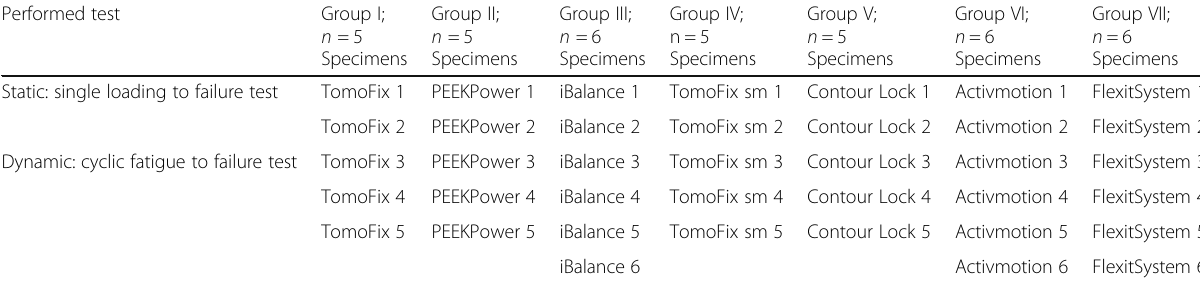
Table 3 Specimen grouping and assignment, depending on used implants and the performed test Performed